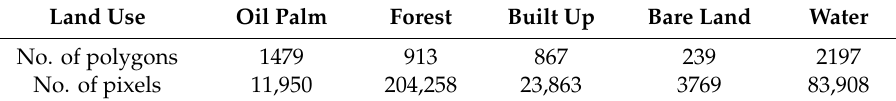
Table 2. Number of samples (polygons) used for the validation of classified satellite data.